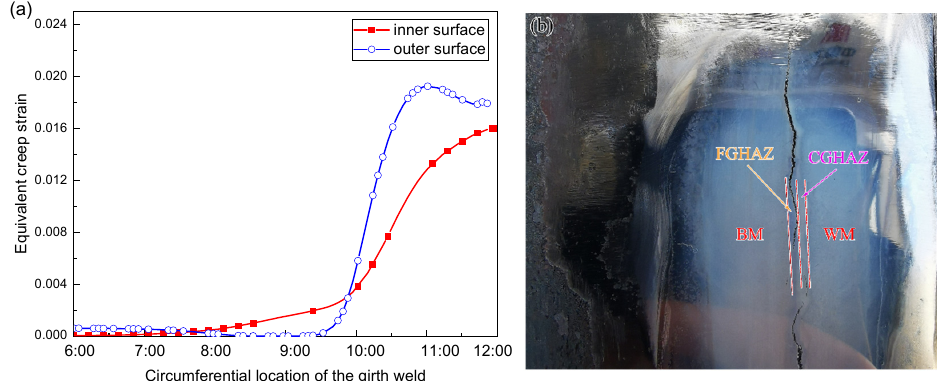
Figure 8. Equivalent creep strain distribution in the FGHAZ of the weld on the horizontal pipe side ( a ) and crack morphology of the weld after being in service for about 20,000 h (b). It is clear from Figure 8a that due to the influence of structural induced stress, there is a clear difference in creep strain in different circumferential locations on the pipe. The creep strain in the FGHAZ at the 6:00 and 8:00 positions are nearly identical between the outer and inner surfaces of the weld, while the creep strain on the inner surface is greater than on the outer surface between the 8:00 and 10:00 positions. The creep strain on the inner surface of the pipe is smaller than on the outer surface between the 10:00 and 12:00 positions. The maximum creep strain is 1.9% and located at the 10:30 position in the FGHAZ on the outer surface, which makes it the weakest part of the welded joint. Steam leakage was observed at this pipe to elbow weld after being in service for about 20,000 h. The crack is located at the FGHAZ of the weld on the horizontal pipe side. The crack initiated around the 10:30 position of the outer surface and then propagated to the inner surface, which is in agreement with the simulation